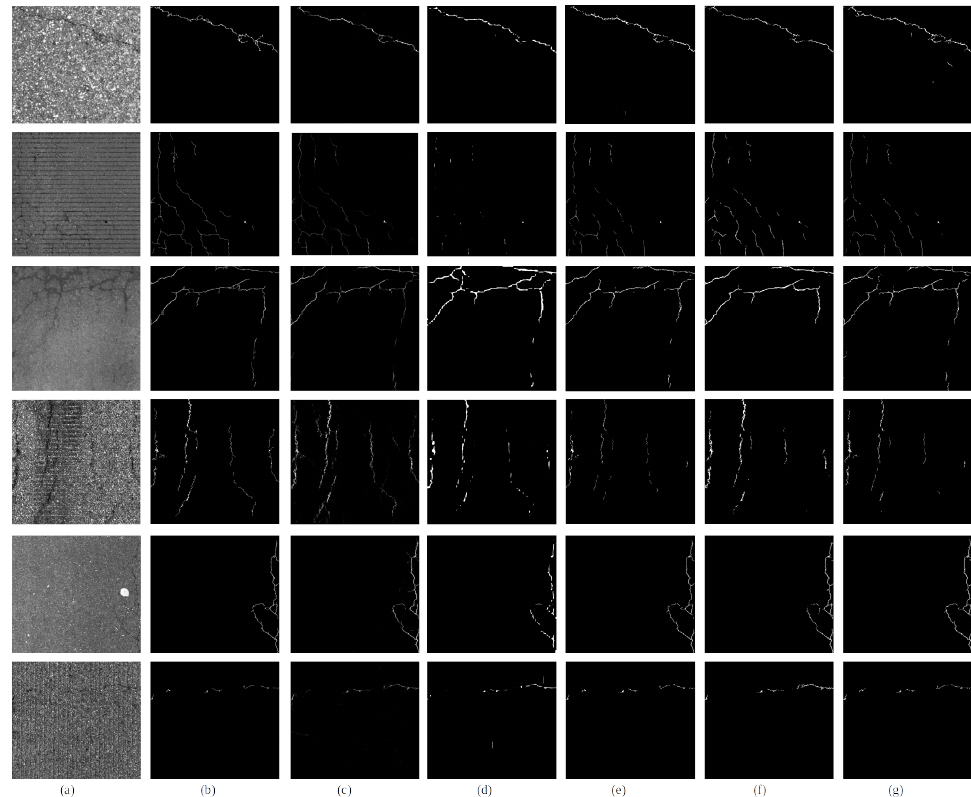
Figure 4. Prediction comparison with other segmentation models. ( a ) Pavement images, ( b ) ground truth, ( c ) U-Net, ( d ) UACANet, ( e ) Double U-Net, ( f ) FCBFormer, ( g ) Ours. Most models can detect distinct cracks as seen in the first row. The performance difference is from the fine-grained cracks. U- Net and UACANet tend to miss tiny cracks, but FCBFormer and our model outperform on detecting fine-grained